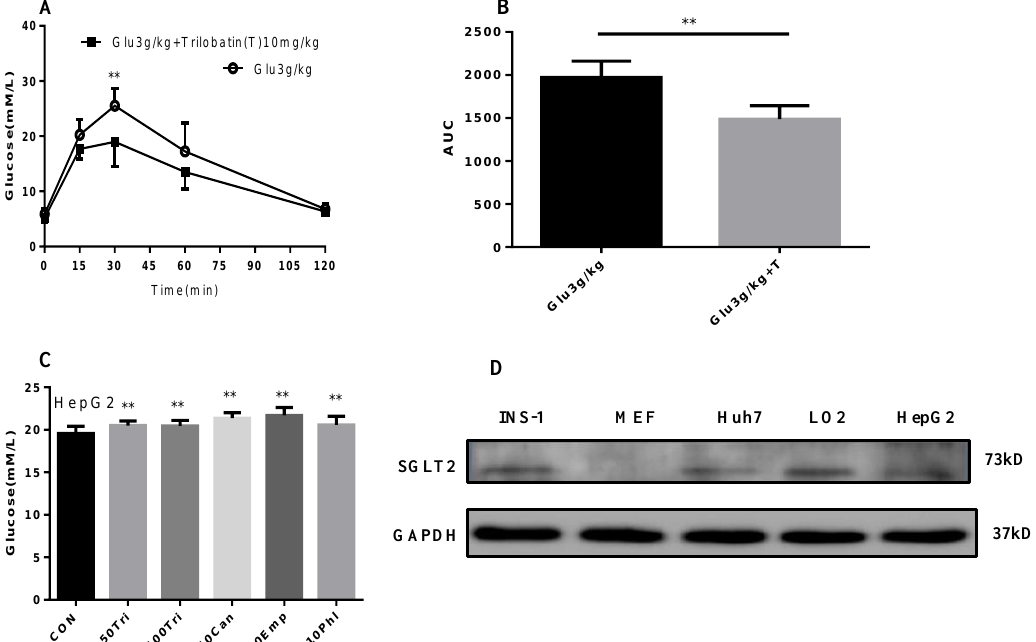
Figure 4. Trilobatin suppressed the intake of glucose in vivo and in vitro. ( A ) After 3 mg / kg glucose was intragastric administrated with or without 10 mg / kg trilobatin, blood glucose was measured at 0, 15, 30, 60 and 120 min. ( A ) the contents of blood glucose at 0, 15, 30, 60 and 120 min, Data are means ± SD ( n = 8), ** p < 0.01 vs. control. ( B ) The area under curve (AUC) of Figure 3A. ( C ) After HepG2 cells were replaced onto 24-well plate and cultured overnight, the cells were washed once with phosphate-bu ff ered saline (PBS) and starved 2 h, and then the media was changed with high glucose (25 mM) completed media, and continued to incubate for 2 h, the supernatant was collected to determine the content of glucose according to the protocol from supplier. Data are means ± SD ( n = 12), ** p < 0.01 vs. control. ( D ) The protein levels of SGLT2 in INS-1, MEF, Huh7, LO2 and HepG2 cells.